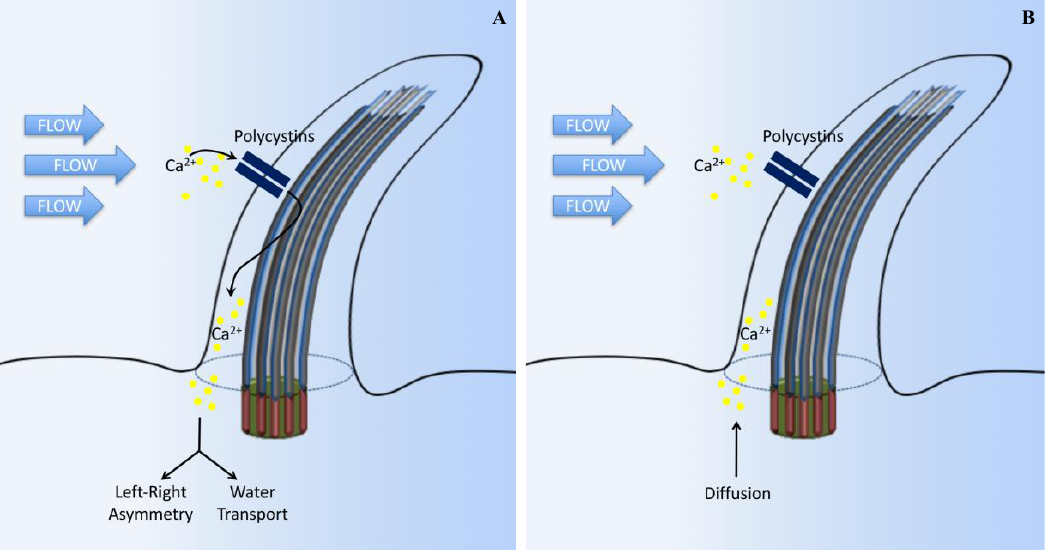
Figure 2. Cilia-dependent calcium signaling. ( A ) The standard established model suggests that primary cilia respond to force through mechanosensation. In this original model, fluid flow bends the cilium, which triggers the opening of calcium-sensitive channel proteins and allows Ca 2+ to enter the cilium. Intracellular signaling cascades are activated by the Ca 2+ influx, leading to altered gene expression on the left side of the embryo, or promoting water transport in the kidneys. ( B ) In another model, ciliary bending in response to fluid force does not open Ca 2+ channels. Instead, Ca 2+ influx, observed in previous experiments, might have been due to diffusion from the cell body or caused by a damaged cilium membrane in response to extreme levels of shear force.